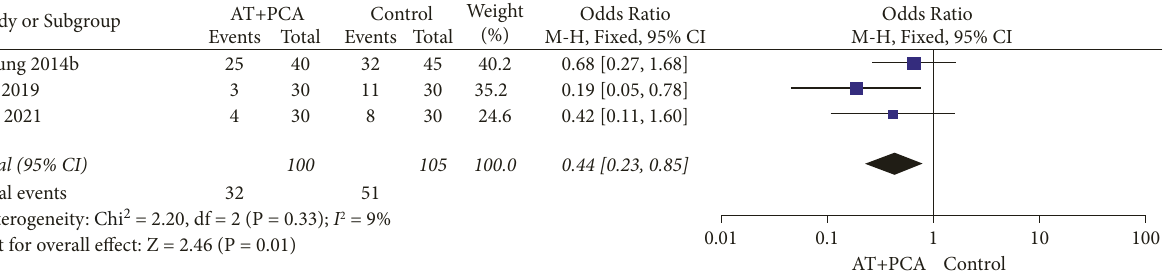
Odds RatioStudy or Subgroup